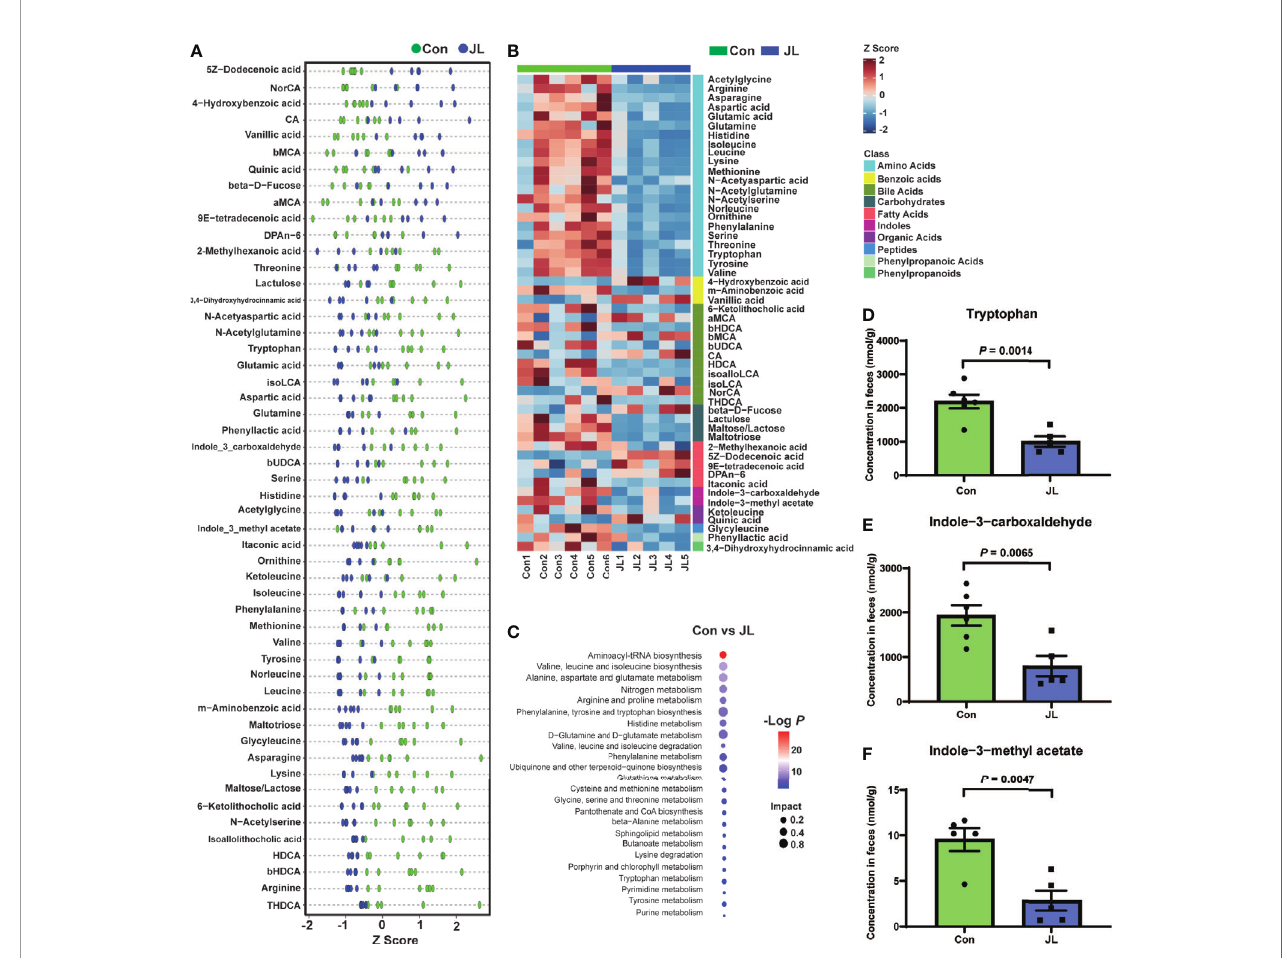
FIGURE 8 | Potential biomarkers of Con (n = 6) and JL (n = 5) groups. (A) Scatter plot of Z scores in each group. (B) Heatmap of Z scores in each group. Blocks in red and blue denote high and low z-score values of potential biomarkers, respectively. (C) Bubble chart of pathway analysis of differential metabolites. (D – F) The concentrations of tryptophan and its derivatives in Con and JL group. (D) Tryptophan, (E) Indole-3-carboxaldehyde, (F) Indole-3-Methyl acetate. Differences were assessed by student ’ s t